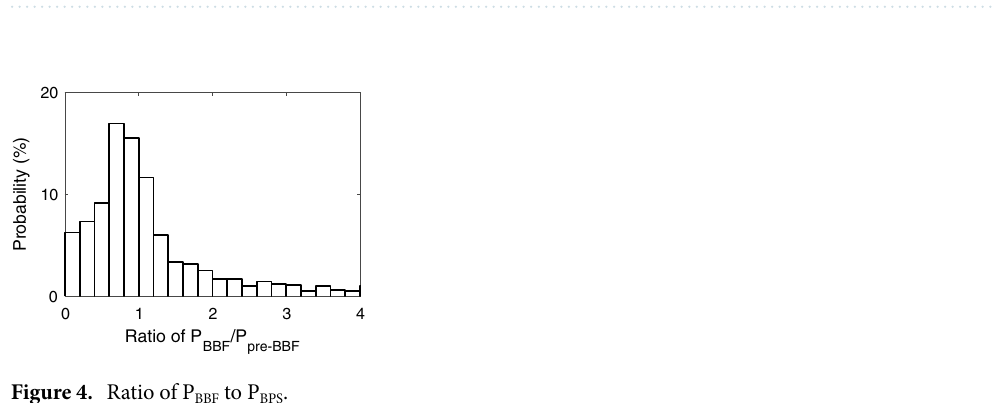
Figure 3. Power spectrum distribution of the turbulent B during the interval of the reconnection jet from 16:23 to 16:35 UT.